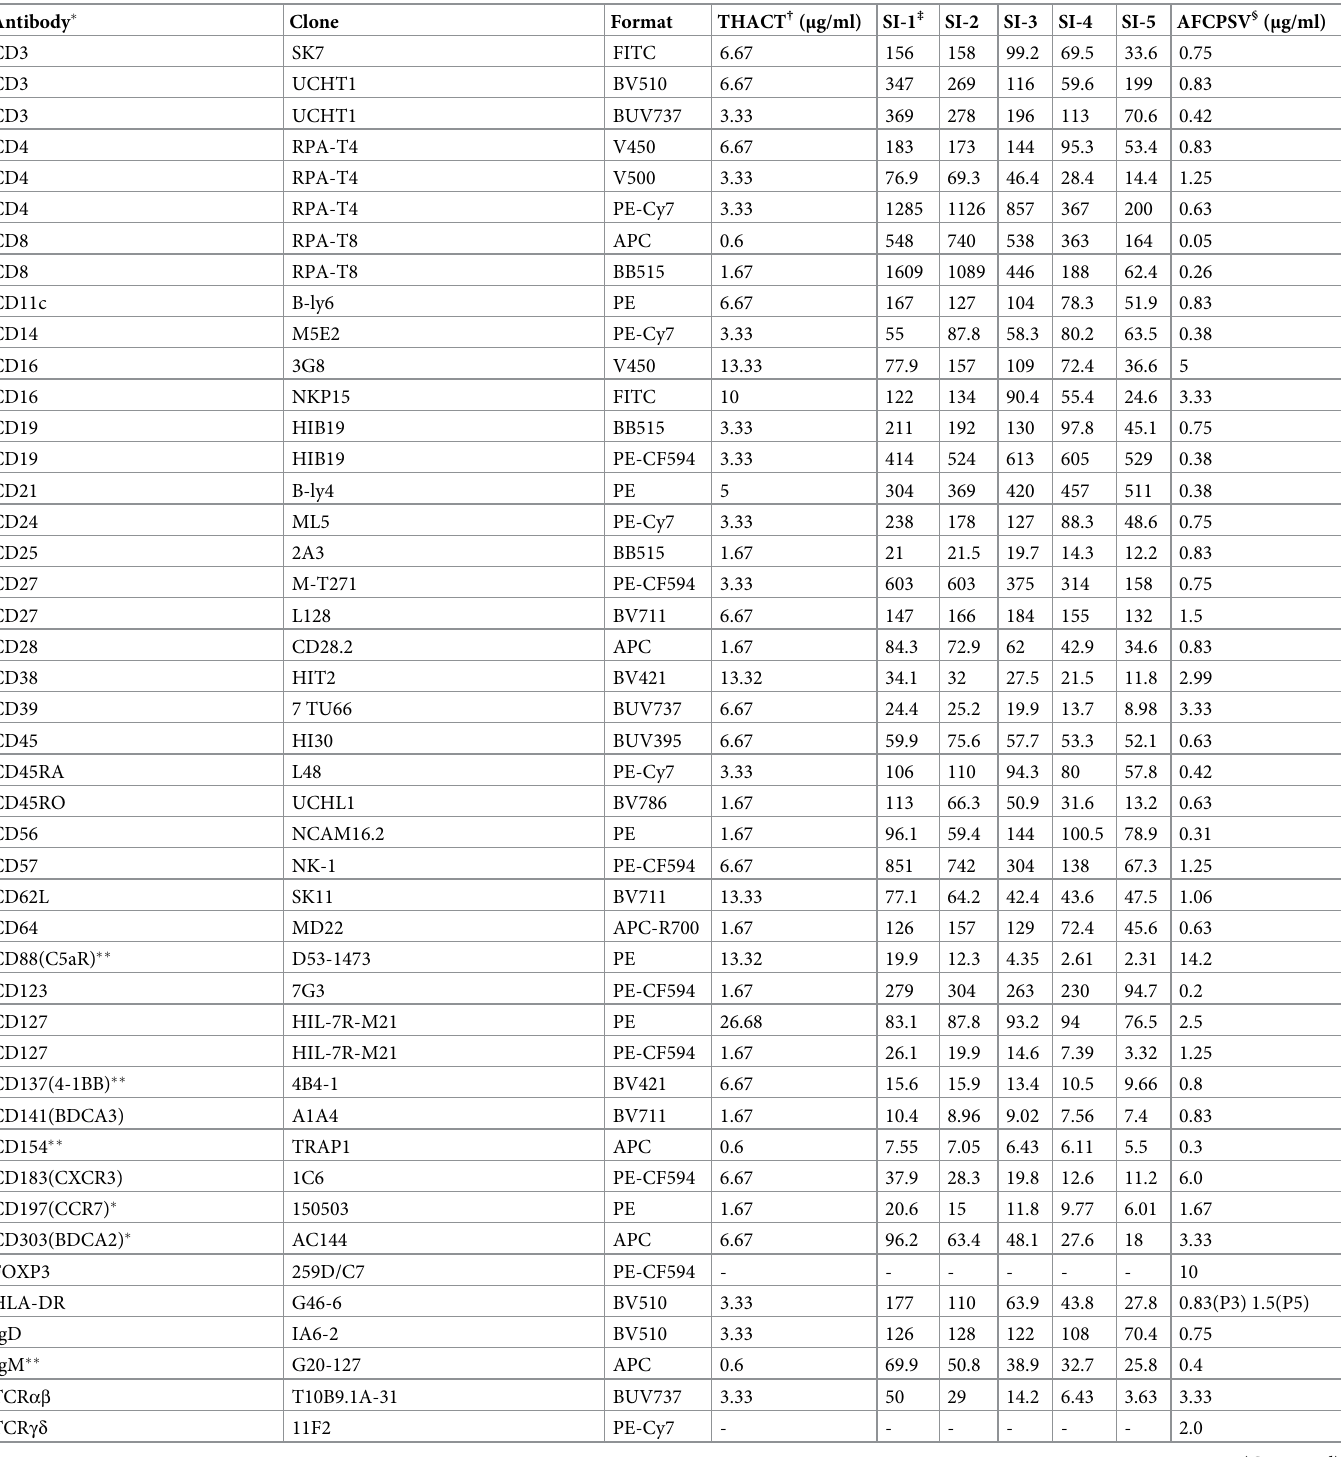
Table 1. Antibodies, staining indexes and usage of antibodies in the